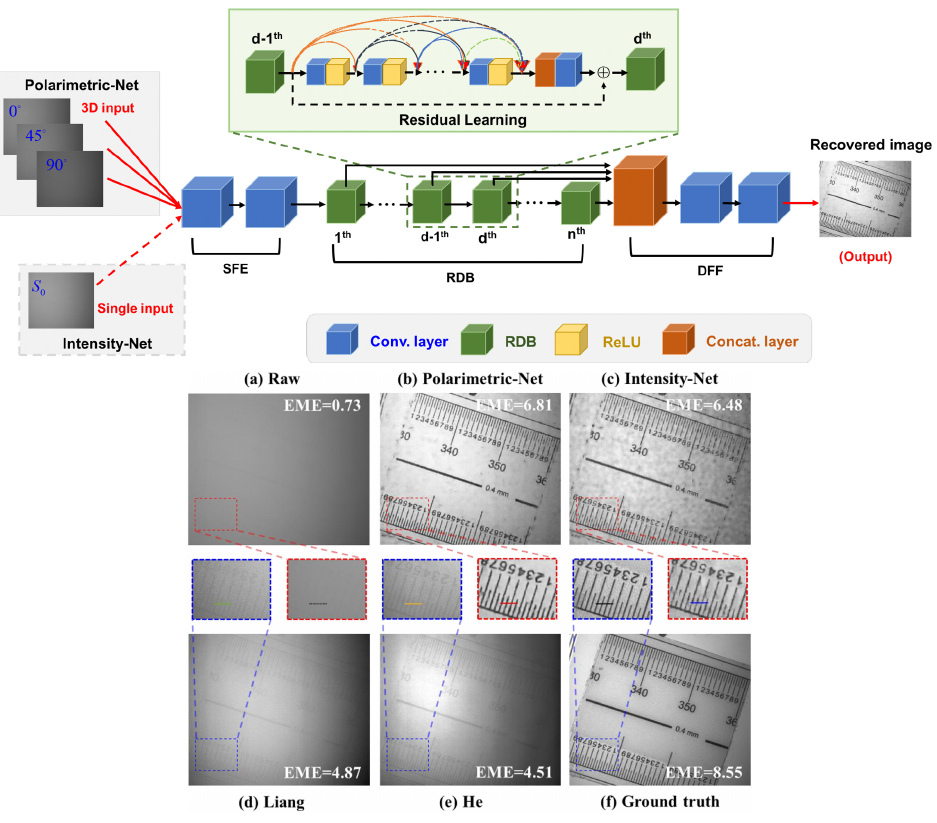
Figure 16. ( Up ) Architecture of polarimetric dense network. ( Down ) The raw image in turbid water and the images recovered by different methods